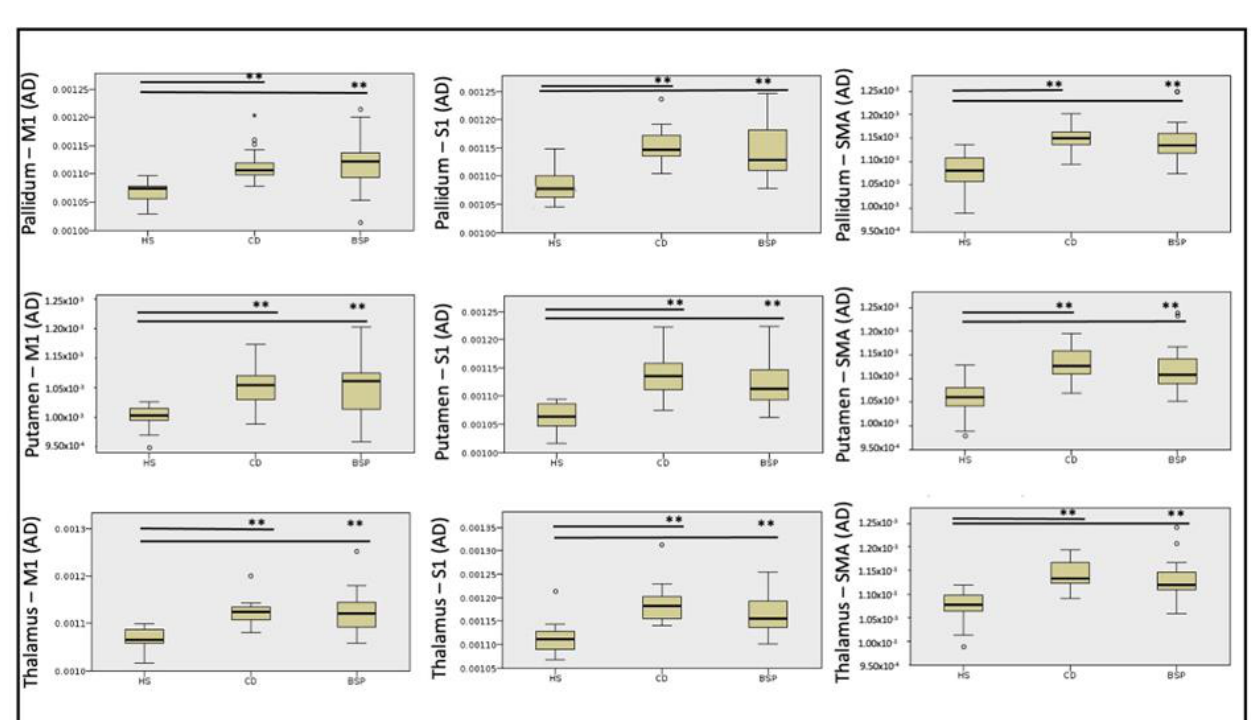
Figure 4. Differences in axial diffusivity (AD) of cortical-subcortical white matter tracts among subjects. HS: healthy subjects; CD: cervical dystonia; BSP: blepharospasm; M1: primary motor cortex head/face region; S1: primary sensory cortex head/upper limb region; SMA: supplementary motor area. Kruskal – Wallis post hoc analysis (* p < 0.05, ** p < 0.001). Circles indicates outliers.